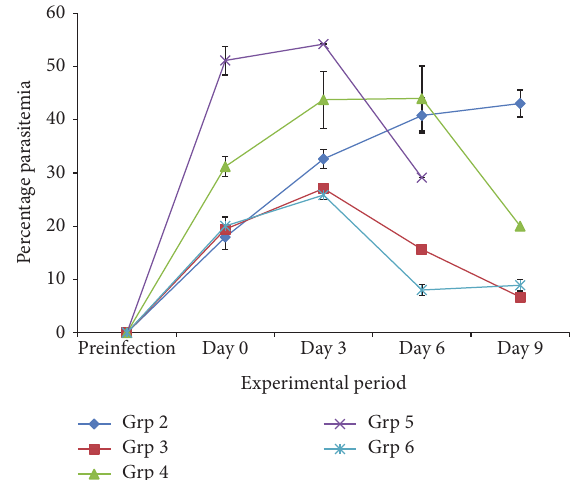
Figure 1: The percentage of parasitized erythrocytes in mice in- fected with P. berghei and treated with aqueous leaf extracts of V. amygdalina and C. papaya, and